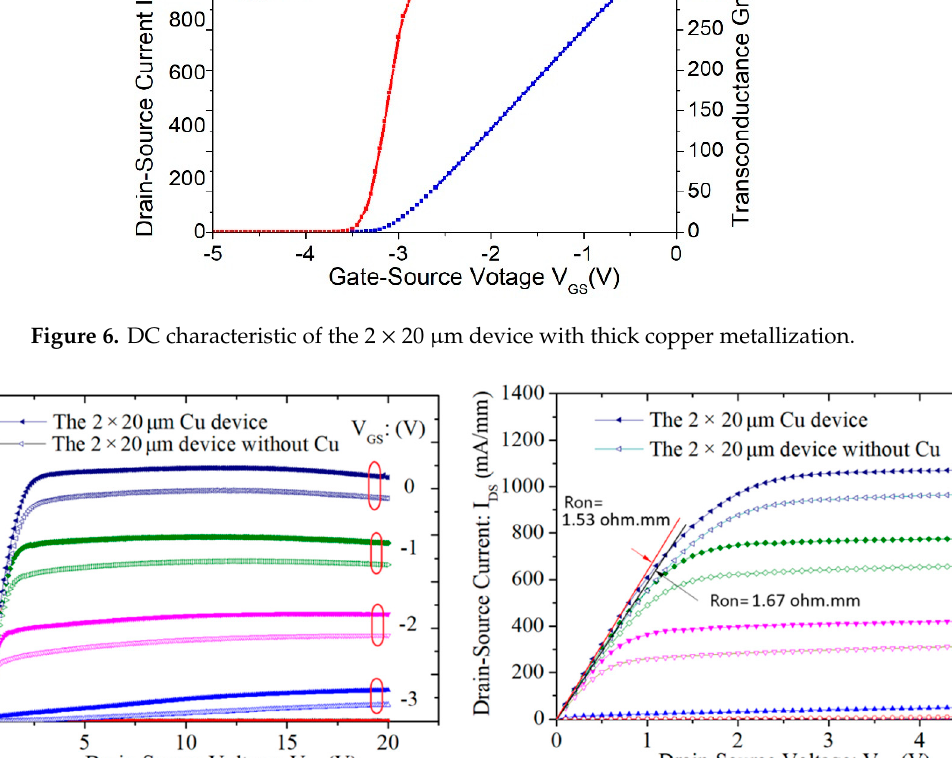
Figure 7. The comparison of DC I–V curves for the device with and without thick copper metallization.